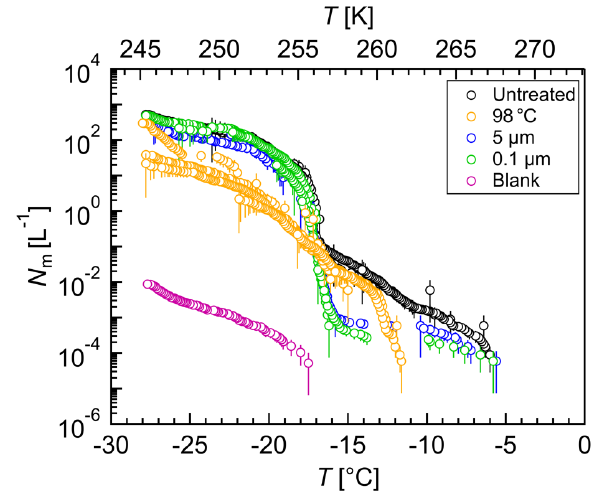
Figure 10. Freezing experiments with aqueous extracts of atmo- spheric aerosols. Cumulative number of IN per liter air ( N m ) vs. temperature ( T ) for untreated (black), heated (yellow), 5µm filtered (blue), 0.1µm filtered (green), and blank (magenta) filter extracts. Droplets of the same dilution of two aliquots were added to a total droplet number of 192 (2 × 96 droplets). The error bars were calcu- lated using the counting error and the Gaussian error propagation. The temperature error is